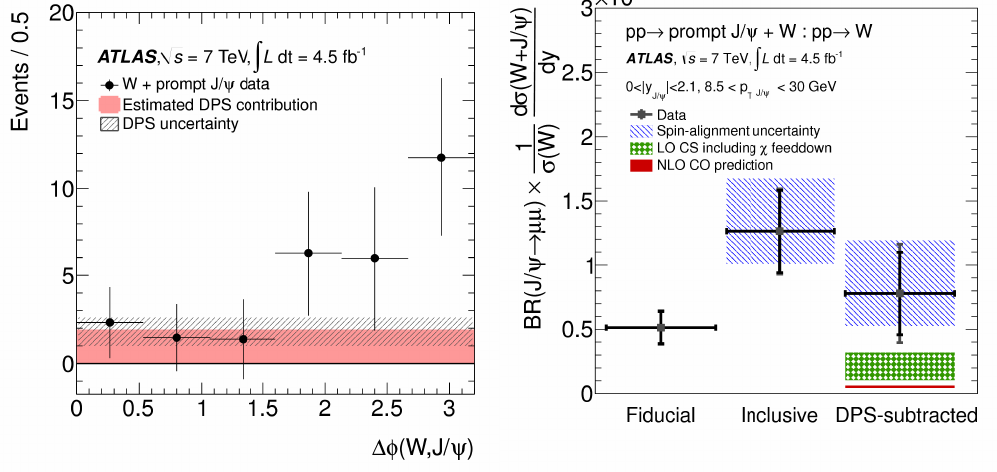
Figure 2: The sPlot-weighted azimuthal angle between the W and the J /ψ with a flat DPS contribution from MC overlaid (left). The W plus the J /ψ production cross-section ratio in the J /ψ fiducial region (Fiducial), after correction for J /ψ acceptance (Inclusive), and after subtraction of the double parton scattering component (DPS-subtracted) (right).